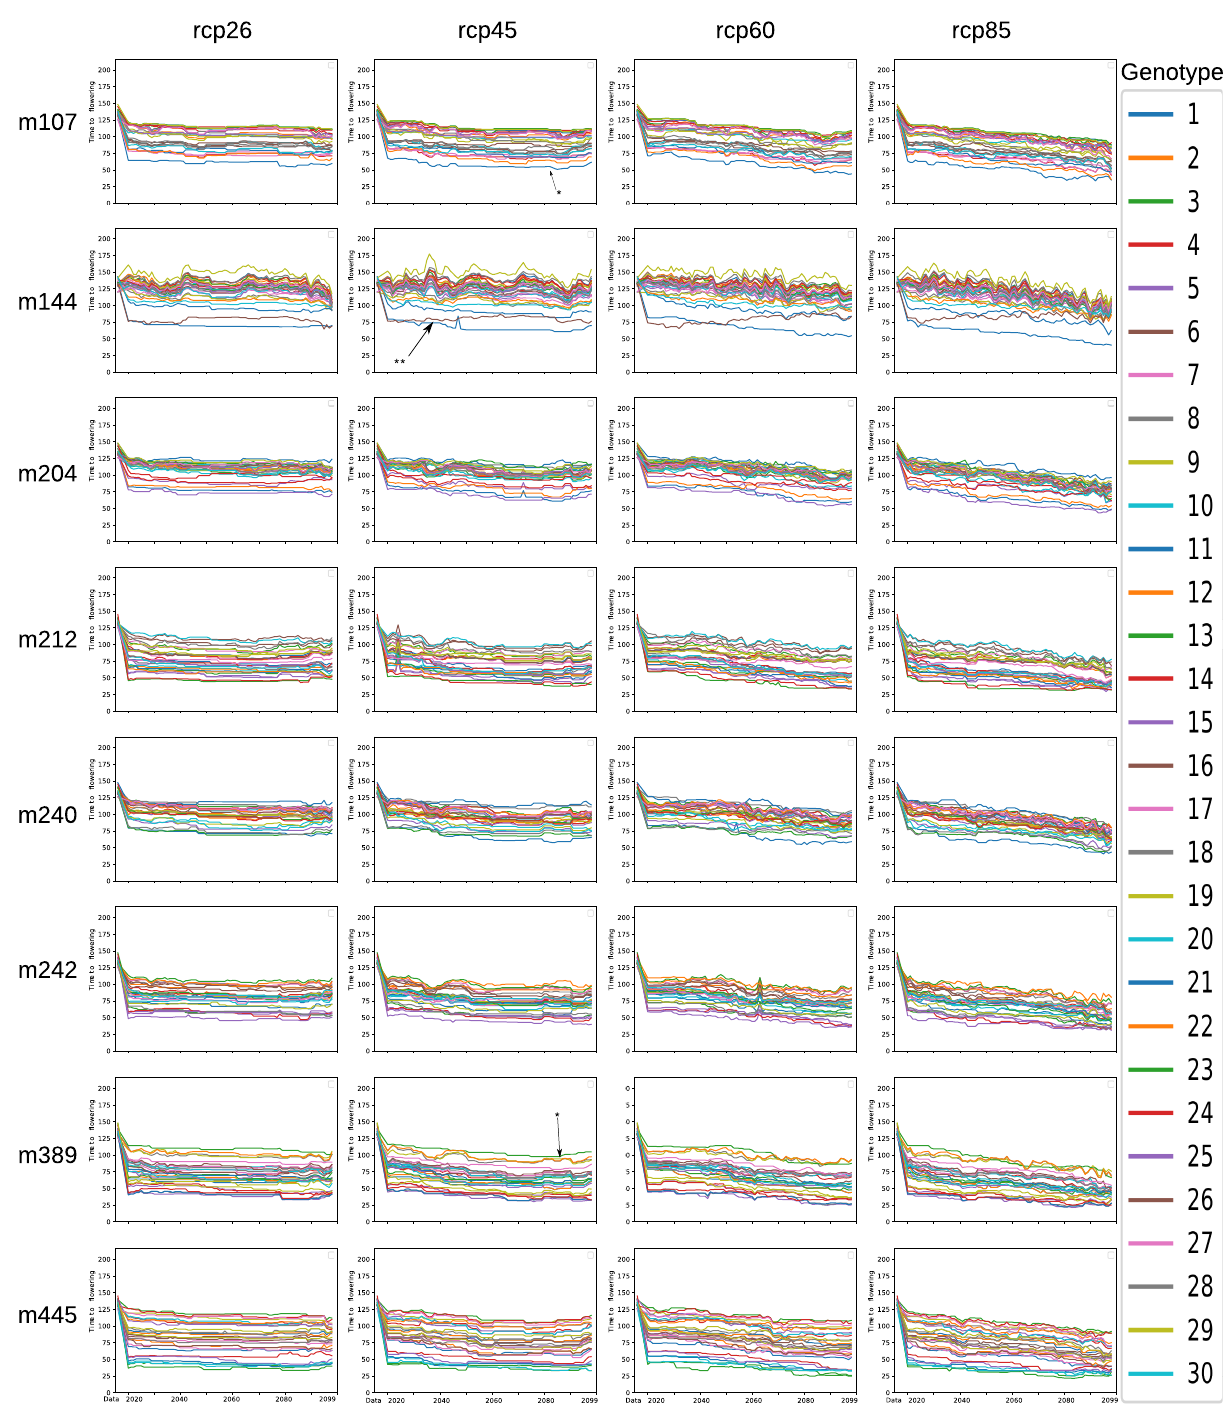
Figure 10. Forecast for time to flowering for 30 genotypes for years from year 2021 to 2099 in Ankara and for sowing date 339 DOY. Each column corresponds to one representative carbon dioxide concentration profile and each row corresponds to one of the ensemble model. The left-most point for each curve corresponds to the time to flowering in the data set. The behavior of the genotypes in model m144 differs from that scenario. Genotypes #8, #21, #26 (originated from Baristepe, Kalkan and Sarikaya) and #1 (unsequenced ac- cessions) have a significant drop in the time to flowering between the value